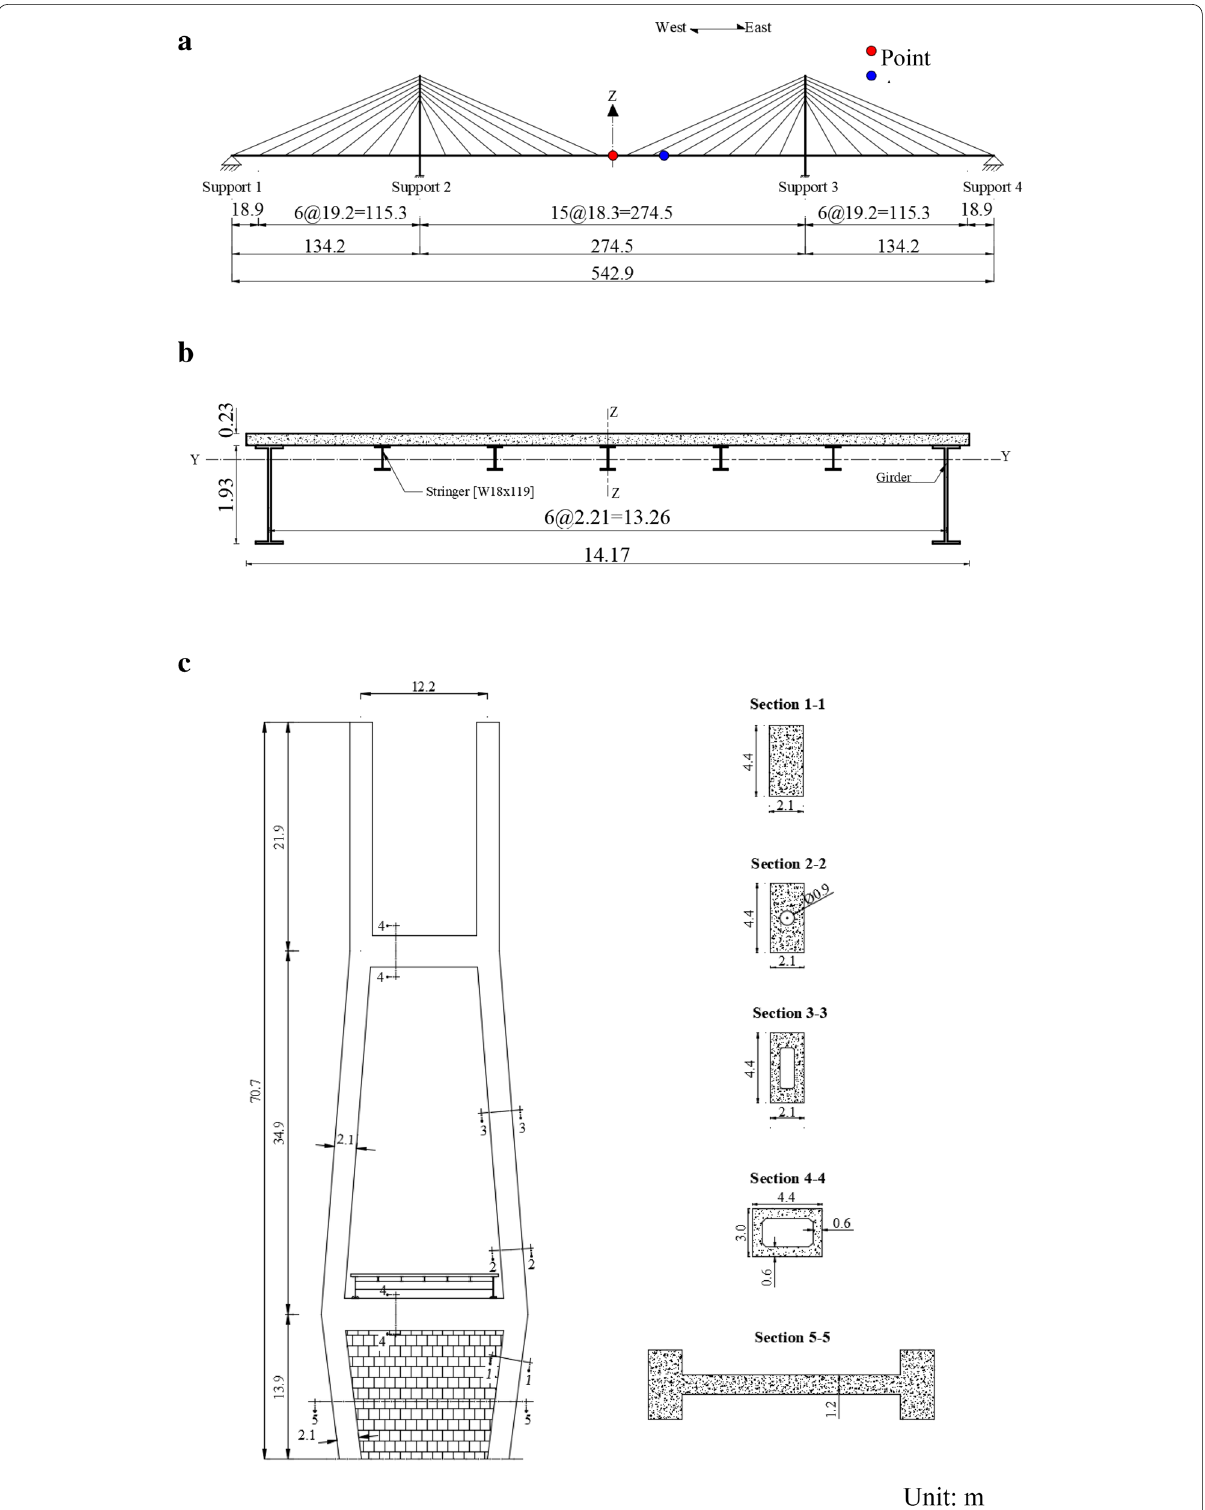
Fig. 1 Bridge configuration: a elevation view, b deck cross section, c pylon